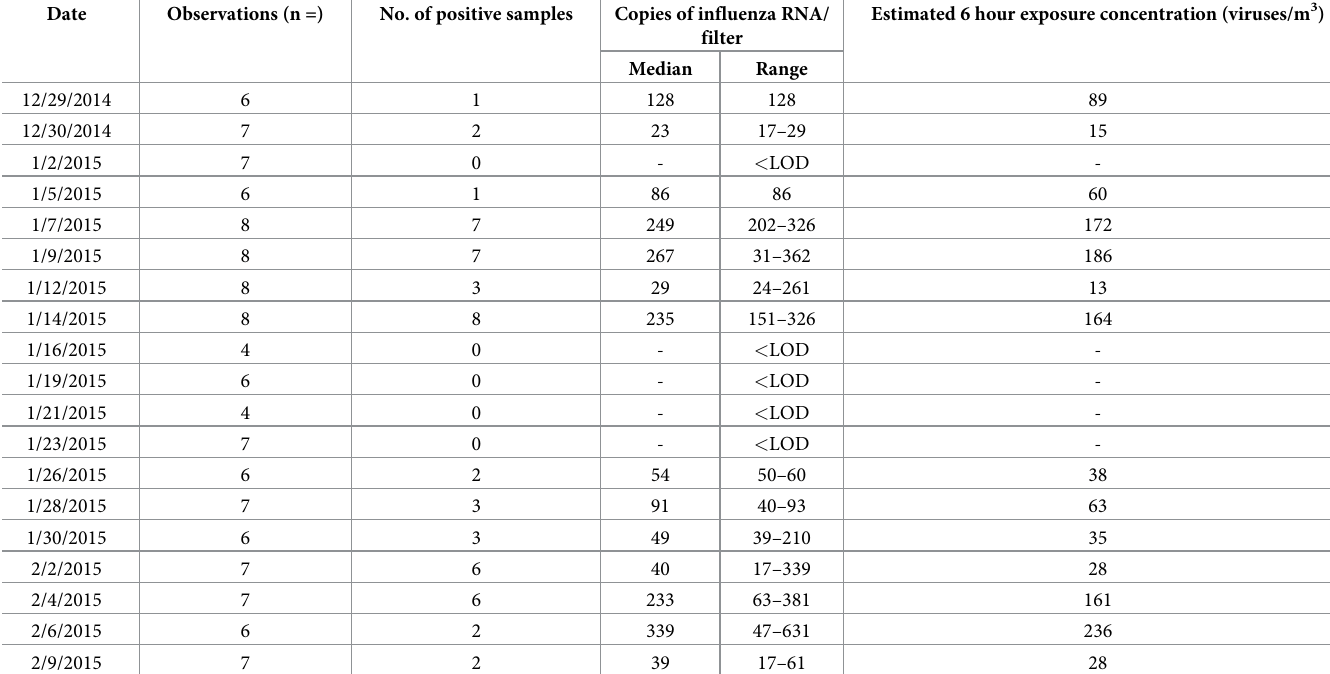
Table 1. Influenza concentrations in individual personal bioaerosol samples over the study period.